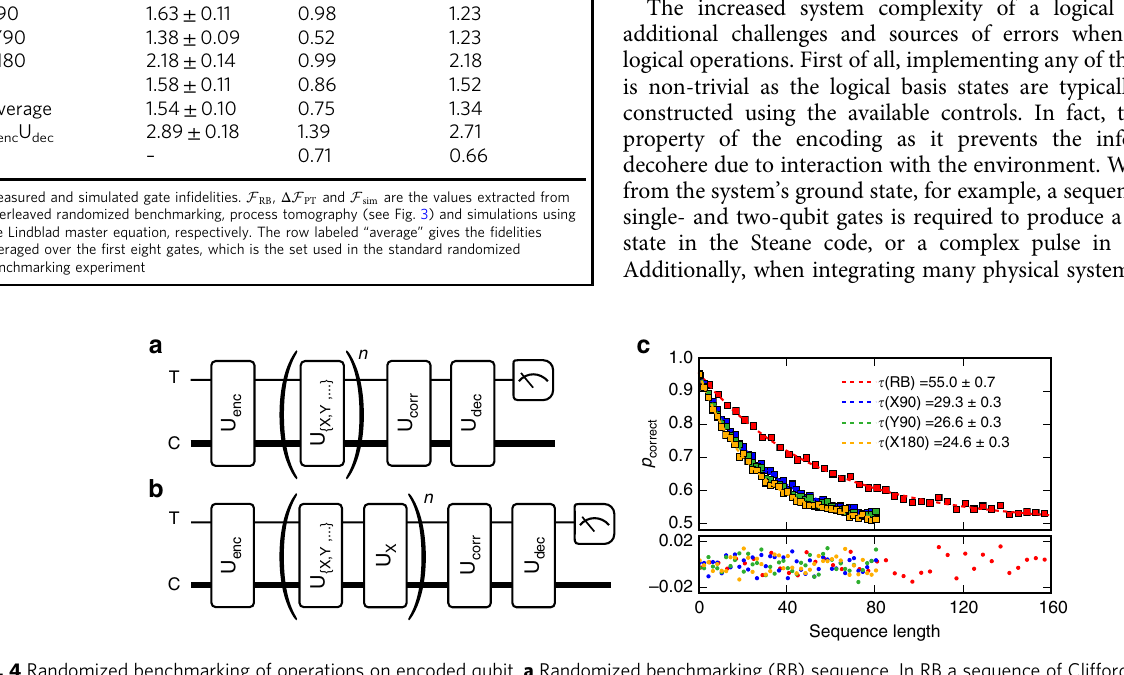
Fig. 4 Randomized benchmarking of operations on encoded qubit. a Randomized benchmarking (RB) sequence. In RB a sequence of Clifford operations of length n is chosen at random (U {X,Y, … } ), followed by the operation which inverts the effect of the sequence (U corr ). In order to apply this technique to the operations on the encoded qubit, we begin the experiment by encoding, and decode before measurement. Our implementation of RB creates a new random gate sequence for every measurement, and is thus not biased by the distribution of sequences which are measured. b Interleaved randomized benchmarking (iRB) sequence: In order to establish the fi delity of a single operation (here, U X ), the operation is interleaved with random operations, and the benchmarking result is compared with the non-interleaved case. c The probability of measuring the correct result vs. sequence length n is fi t to a two parameter model p correct = 0.5 + Ae − n / τ . The lower panel shows the fi t residuals. Each data point is the result of 2000 averages, with a new sequence realization every shot. The error averaged over all gates is computed as r = c (1 − e − 1/ τ (RB) )/2 26 . The average error for a single gate X is computed as r ( X ) = c (1 − e 1/ τ ( X ) − 1/ τ (RB) )/2 27 . The factor c = 1.7 ± 0.1 is a correction factor to compensate for the underestimation of the error rate in the presence of